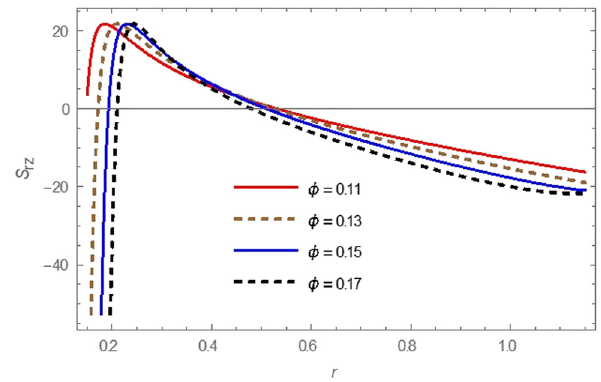
Figure 7: E ff ect of di ff erent values of W e on stress with ϵ 0.15 =